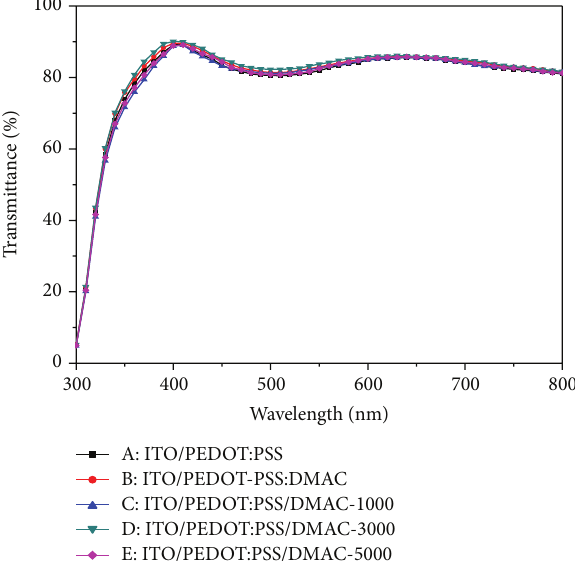
Figure 6: The transmission spectrum of ITO/PEDOT:PSS thin film.